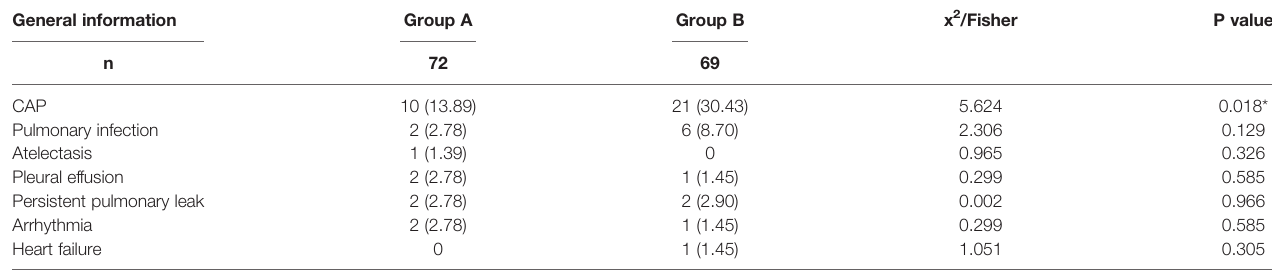
TABLE 3 | Comparison of postoperative complications between the two groups. General information